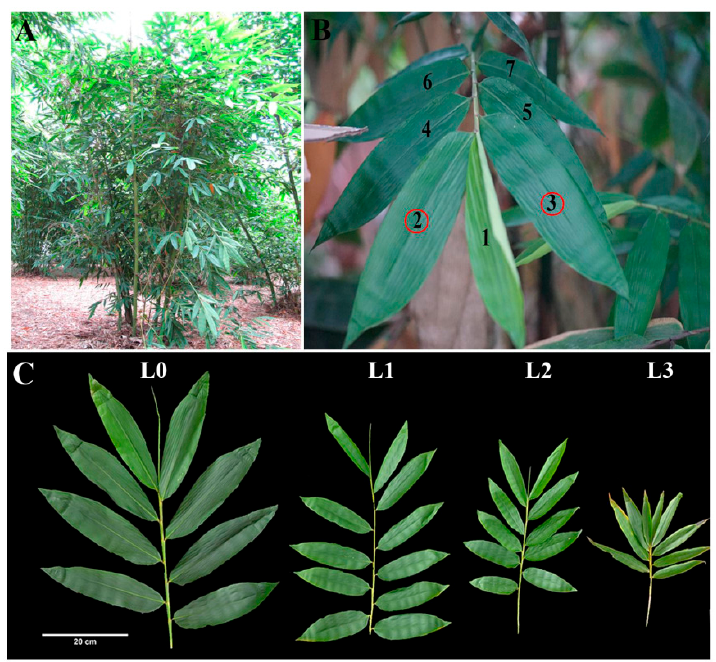
Figure 1. Tissues sampled for RNA-seq and protein analyses of D. latiflorus . ( A ) External morphology of D. latiflorus , a cluster-growing bamboo, shown in situ. ( B ) Leaves were selected from the 2nd and 3rd knob of the branch apex. ( C ) The branches of D. latiflorus can be divided into four growth stages during floral transition, including the large foliage leaves (L0), small foliage leaves (L1), large flowering leaves (L2), and small flowering leaves (L3). L0 belongs to the vegetative clumps. L1, L2, and L3 belong to the same reproductive ramets with at least one pole blooming.